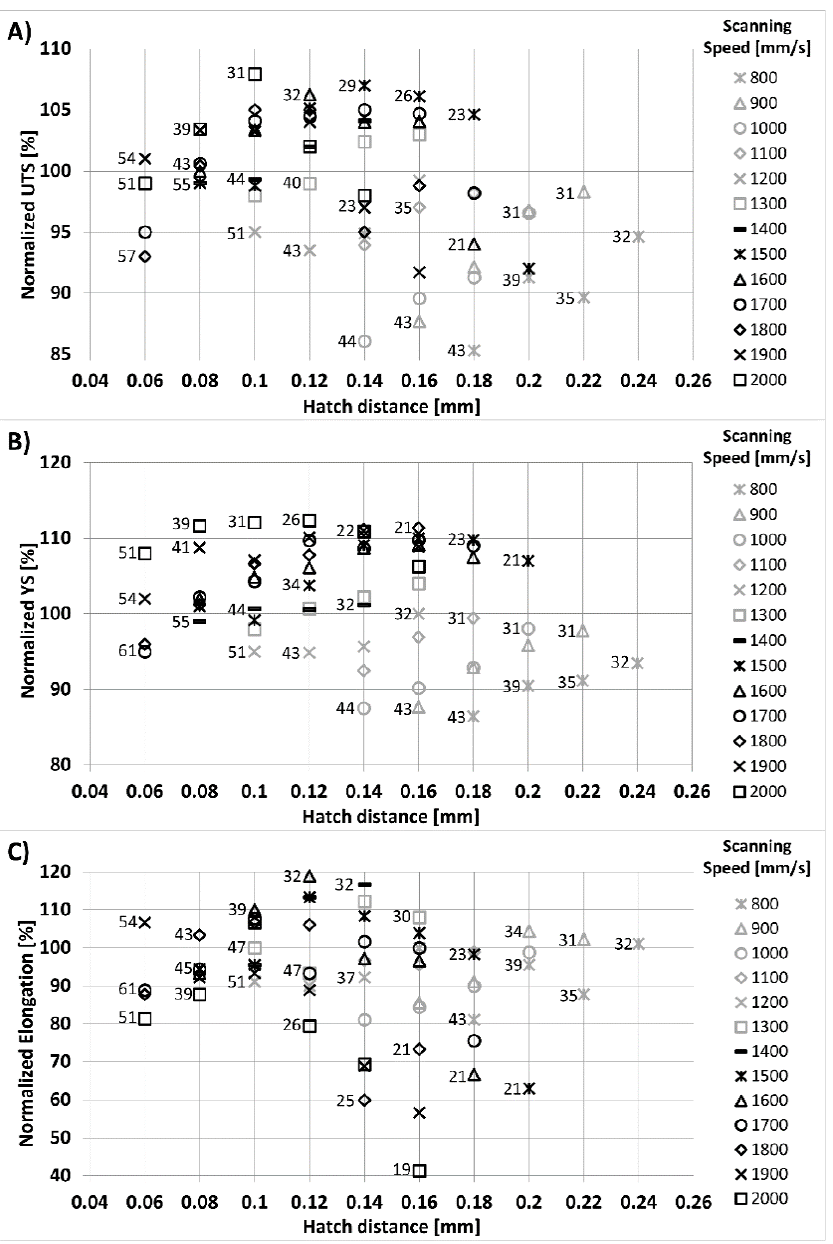
Figure 8. Full set of tensile results of step 1 and step 2 of the analysis. For each hatch distance, values of VED [J/mm 3 ] are shown next to the experimental points that provided the highest, lowest and medium values of the plotted mechanical property. ( A ) Normalized UTS; ( B ) Normalized YS; ( C ) Normalized elongation.